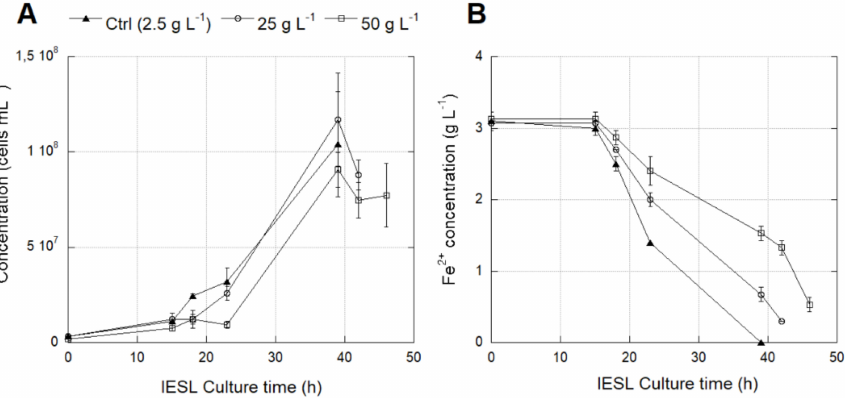
Figure 8. Cell growth ( A ) and Fe 2+ consumption ( B ) of L. ferriphilum IESL-25 cultured under different SO 4 2 − concentrations (g L − 1 ). Vertical bars represent the standard deviation (SD) calculated with biological